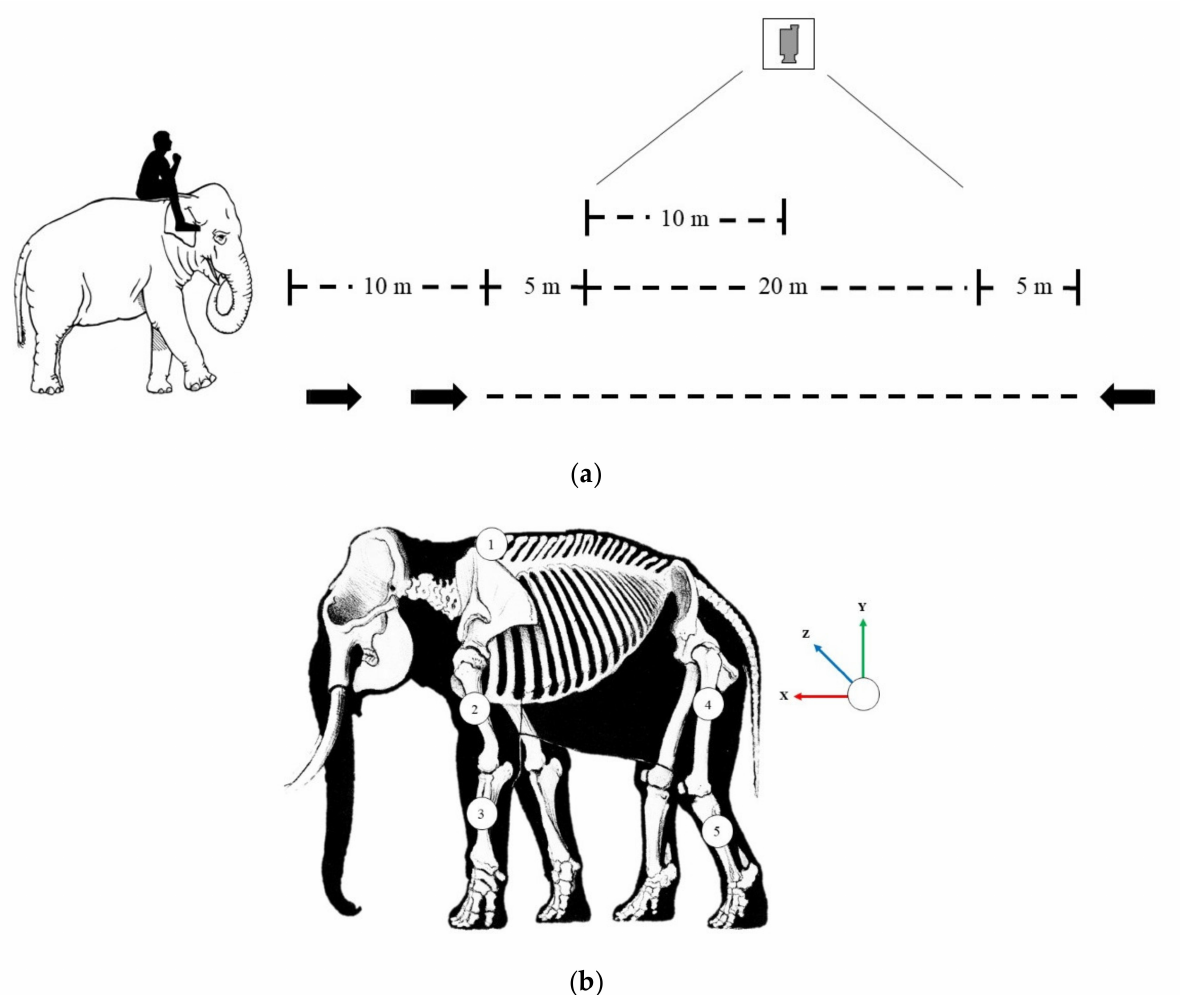
Figure 1. ( a ) Schematic of how gait biomechanics data were collected and positions of the five inertial measurement units at the fore- and hindlimbs. ( b ) A trackway-aligned system determined by arranging the X, Y, and Z axes with the